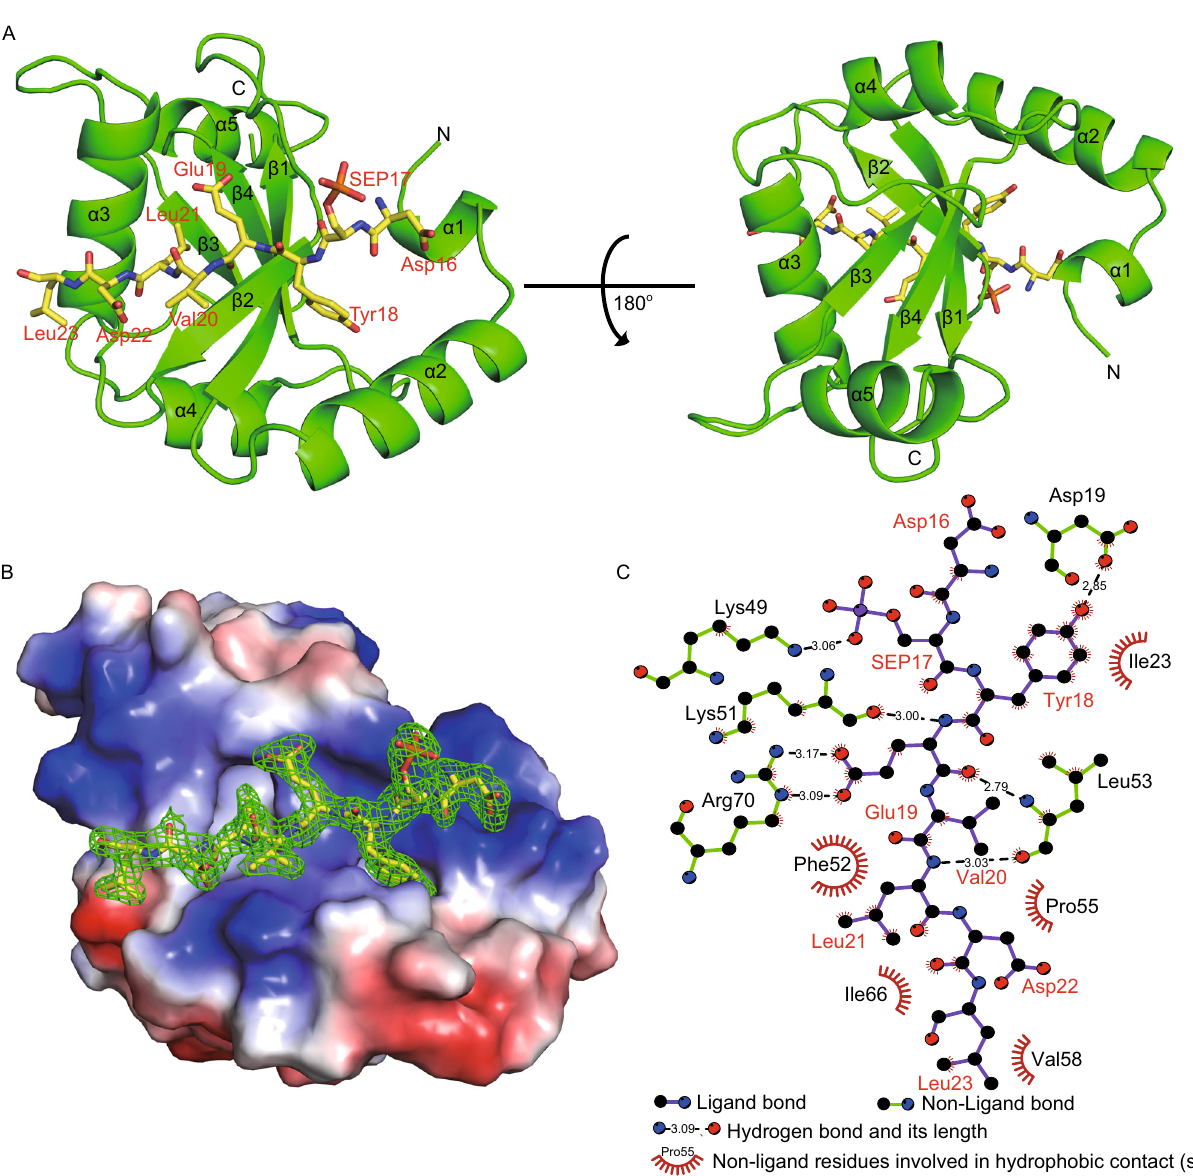
Fig. 2. Crystal structure of LC3B-FUNDC1 pS 17 peptide complex. (A) Cartoon representation of LC3B (green) in complex with the FUNDC1 pS 17 peptide (yellow). In the peptide, the phosphorylated Ser17 is labeled as SEP17. (B) The electrostatic potential of the LC3B-FUNDC1 pS 17 peptide complex surface, in which positively charged, negatively charged and neutral areas are represented in blue, red and white, respectively. The 2Fo-Fc omit density map of the FUNDC1 pS 17 peptide was contoured at 1.0 σ (green). (C) Schematic representations of the recognition of FUNDC1 pS 17 peptide (colored purple and labeled in red) by LC3B (colored green and labeled in